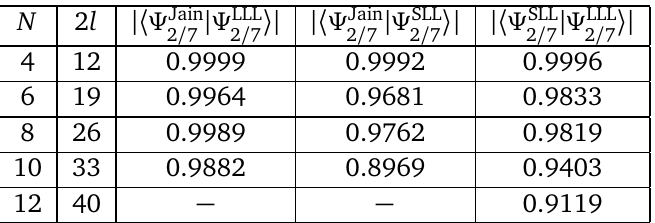
Table 2: Absolute value of the overlap of the exact Coulomb ground state at ν = 2 / 7 〉 and second Landau level (SLL), | Ψ SLL in the lowest Landau level (LLL), | Ψ LLL 2 / 7 〉 obtained in the spherical geometry for N electrons at the 2 / 7 Jain state | Ψ Jain 2 / 7 2 l = 7 N / 2 − 2. For comparison, in the last column, we have shown the overlap between the exact LLL and SLL states. We have not been able to construct the 2 / 7 Jain state for N = 12 electrons, so its overlap with the exact states is currently un- available (indicated by − ). | Ψ LLL 〉| N 2 l |〈 Ψ Jain 2 / 7 2 / 7